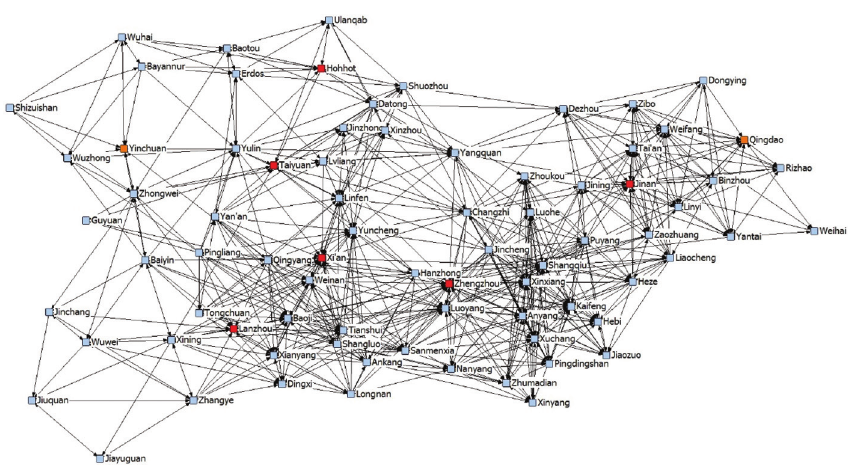
Figure 10: Structure of city networks in the Yellow River basin.